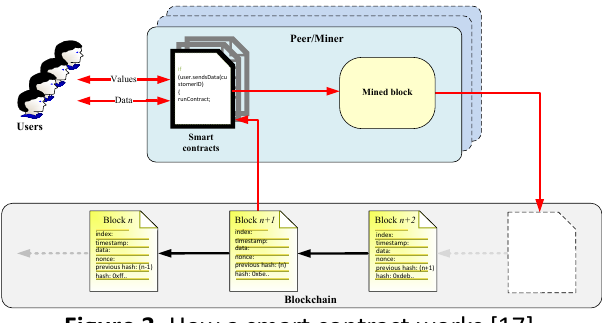
Figure 3. How a smart contract works